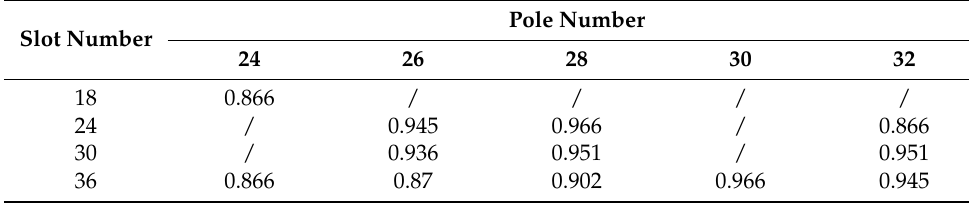
Table 3. The winding factor of the fraction slot